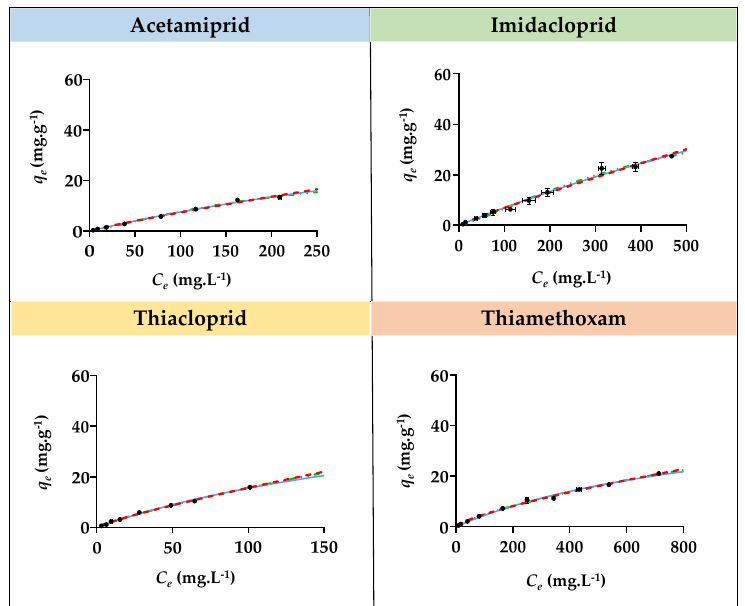
Figure 4. Adsorption isotherms curves for imidacloprid, acetamiprid, thiacloprid, and thiamethoxam insecticides with [Si][N 3222 ]Cl. The black dots correspond to experimental data, the continuous blue line corresponds to the fitting of the experimental data with the Langmuir model, the red dashed line corresponds to the fitting with the Freundlich model, and the green dashed and pointed line corresponds to the fitting with the SIPS model.